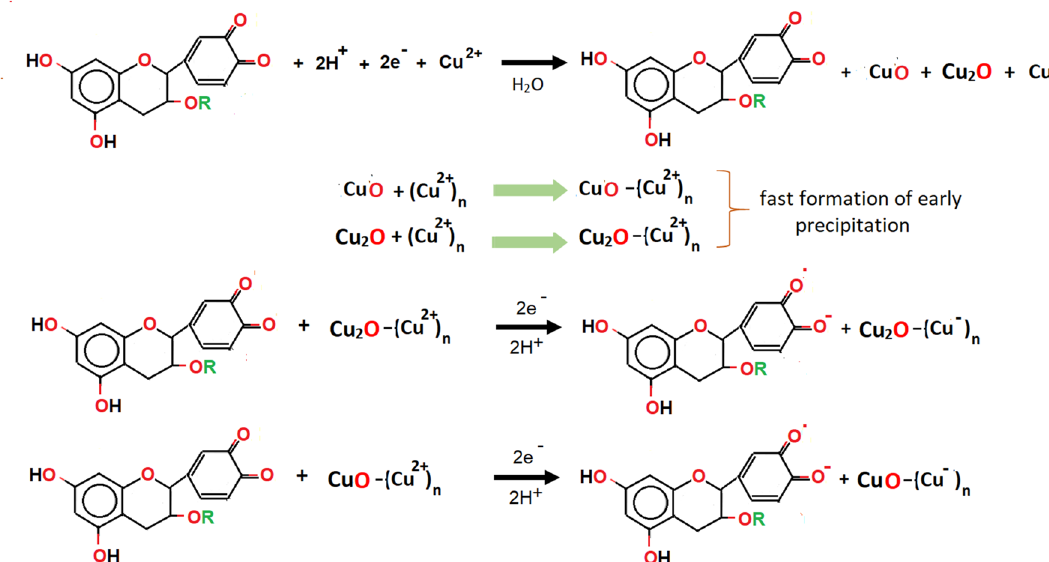
Figure 2. Prediction of pathway mechanisms involved in the formation of Cu-based oxide nanostructures. The reduction of Cu 2+ is due to the resulting species of –OH link from the quinone in